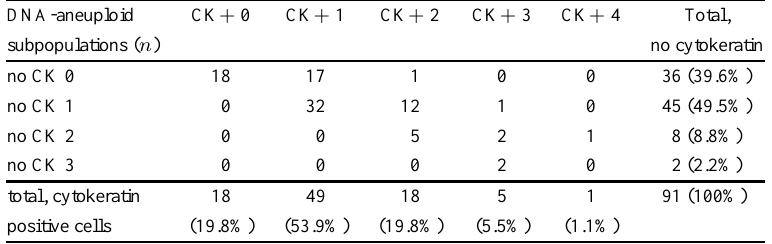
Cervical cancer detection of DNA-aneuploid subpopulations dependent on gating of cytokeratin positive cells